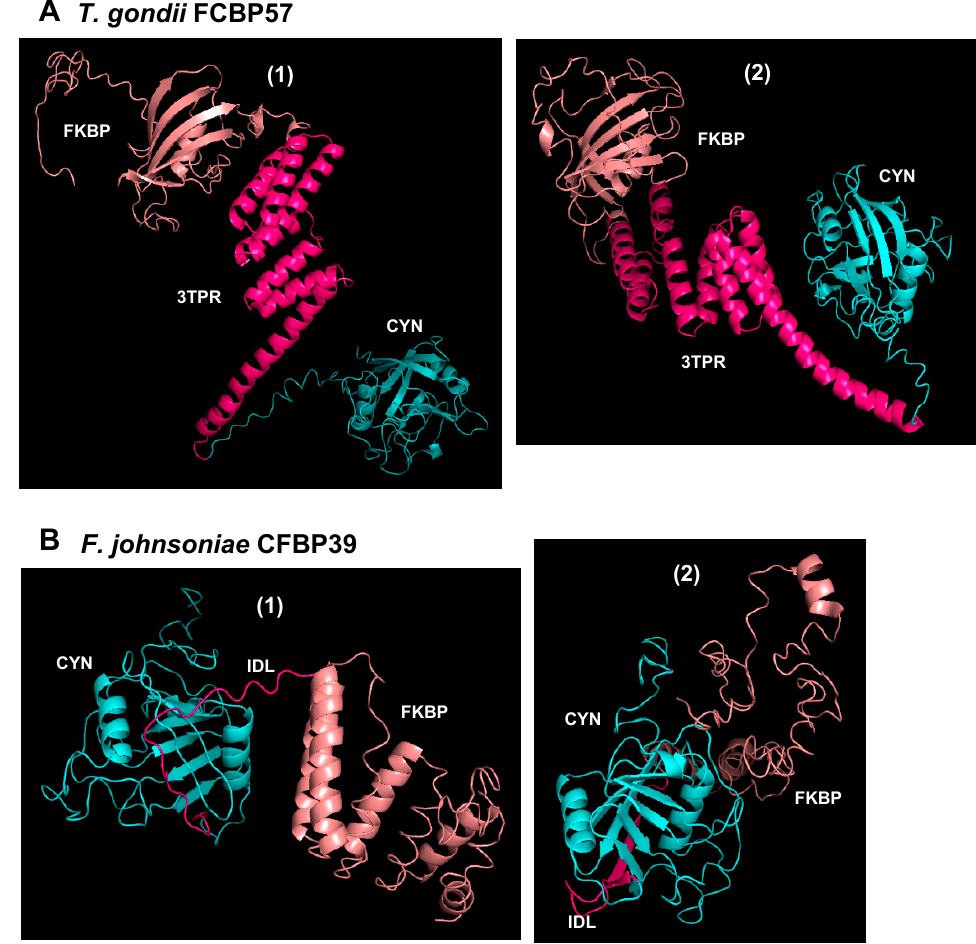
Figure 3. Homology-based modelling of three-dimensional structures of representative ( A ) FKBP-3TPR-CYN (FCBP) and ( B ) CYN-(linker)-FKBP (CFBP) proteins, deduced by I-TASSER and drawn with PyMOL (https://pymol.org, Schrödinger, LLC, USA), as described before [17]. As indicated, the proteins are from Toxoplasma gondii and Flavobacterium johnsoniae , with theoretical molecular mass of 57 kDa and 39 kDa, respectively. The domains are color-coded: CYN domain, cyan; 3TPR linker in Toxoplasma gondii FCBP57 (TgFCBP57) or the intrinsically disordered linker (IDL) in FjCFBP39 (see Figure 2), pink; FKBP domain, salmon color. As seen, the flexibility of the linkers in both polypeptides clearly allowed large changes in the relative orientation between the CYN and FKBP domains, and two arbitrarily chosen conformers (numbered 1 and 2) are presented here.